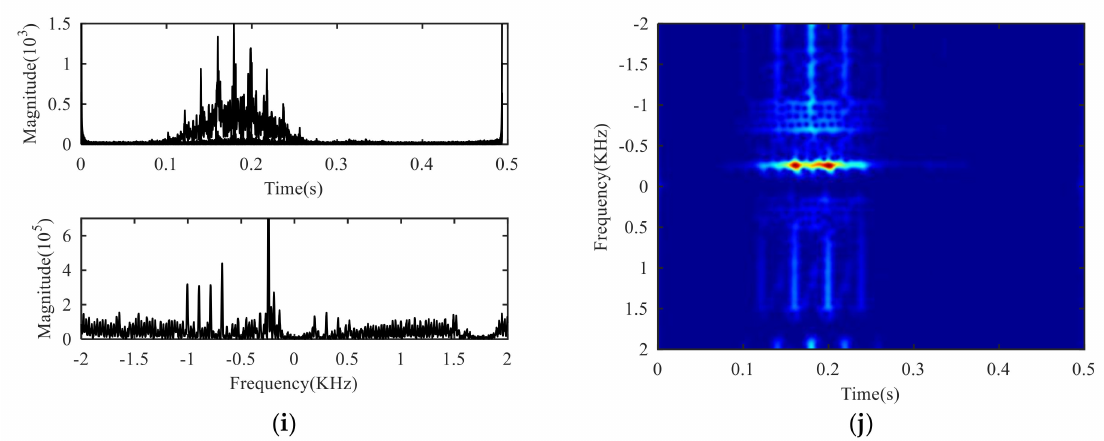
Figure 10. Analysis of helicopter data: ( a ) Original signal in time domain and frequency domain, ( b ) original signal in time-frequency domain, ( c ) reconstruction in time domain and frequency domain by CVMD, ( d ) reconstruction in time-frequency domain by CVMD, ( e ) reconstruction in time domain and frequency domain by LMD, ( f ) reconstruction in time-frequency domain by LMD, ( g ) reconstruction in time domain and frequency domain by EMD, ( h ) reconstruction in time-frequency domain by EMD, ( i ) result in time domain and frequency domain by MTI, ( j ) result in time-frequency domain by